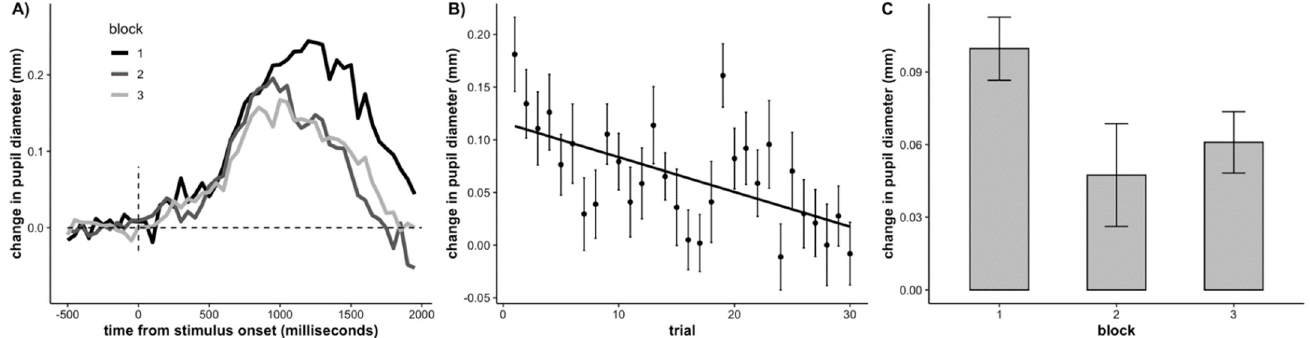
Figure 4. ( A ) Waveforms of the task-evoked pupillary response by block, ( B ) Average change in pupil size at target onset for each trial, ( C ) Average change in pupil size at target onset across each block. Error bars represent +/ − one standard error.